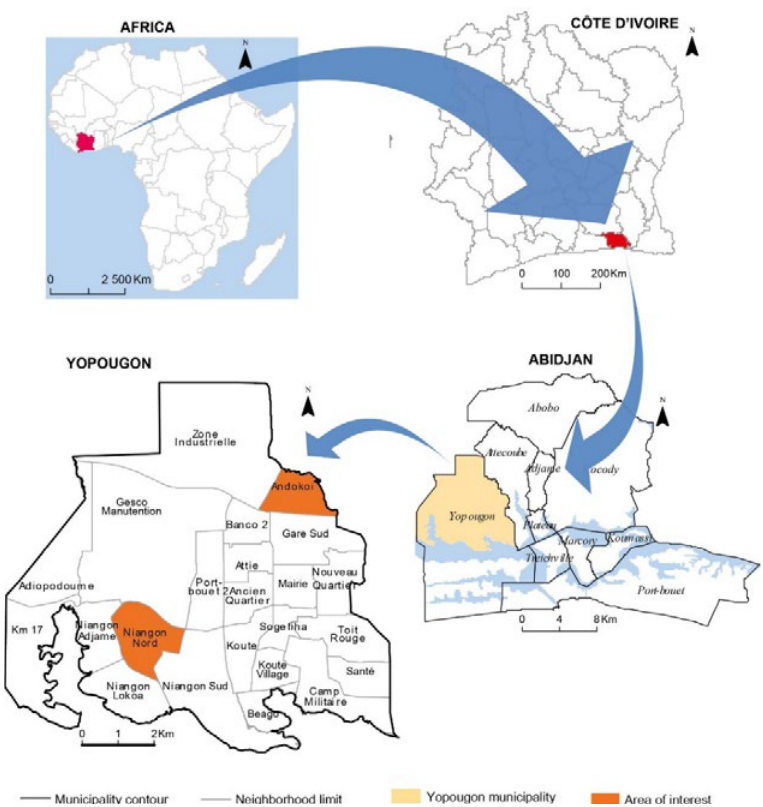
Fig. 1: Geographic location of the study area in Yopougon Municipality at the north ‐ west of the city of Fig. 1. Geographic location of the study area in Yopougon Municipality at the north-west of the city of Abidjan in Cote d’Ivoire (West Abidjan in Cote d’Ivoire (West Africa)